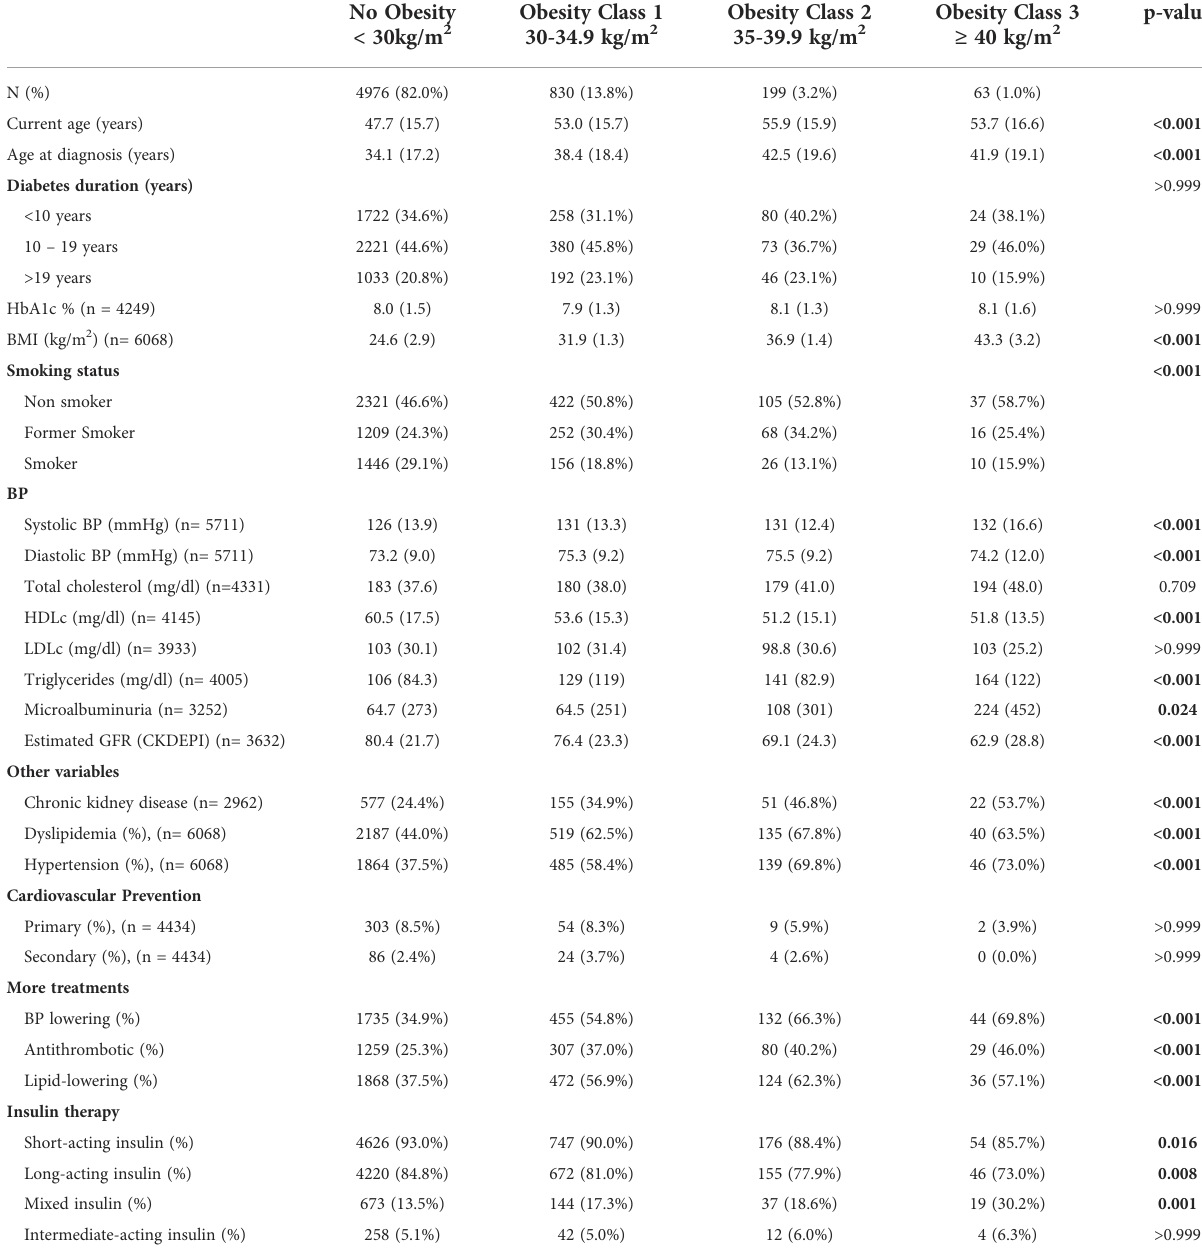
TABLE 2 Characteristics of T1D according to the different categories of body mass